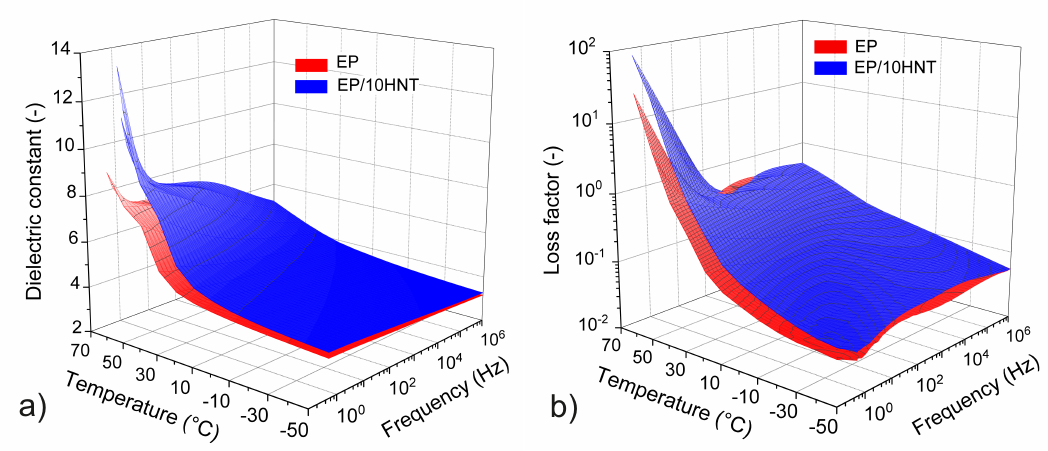
Figure 5. Temperature-frequency dependencies of the ( a ) dielectric constant and ( b ) loss factor for the material based on an epoxy resin and for an epoxy composite with 10 wt%